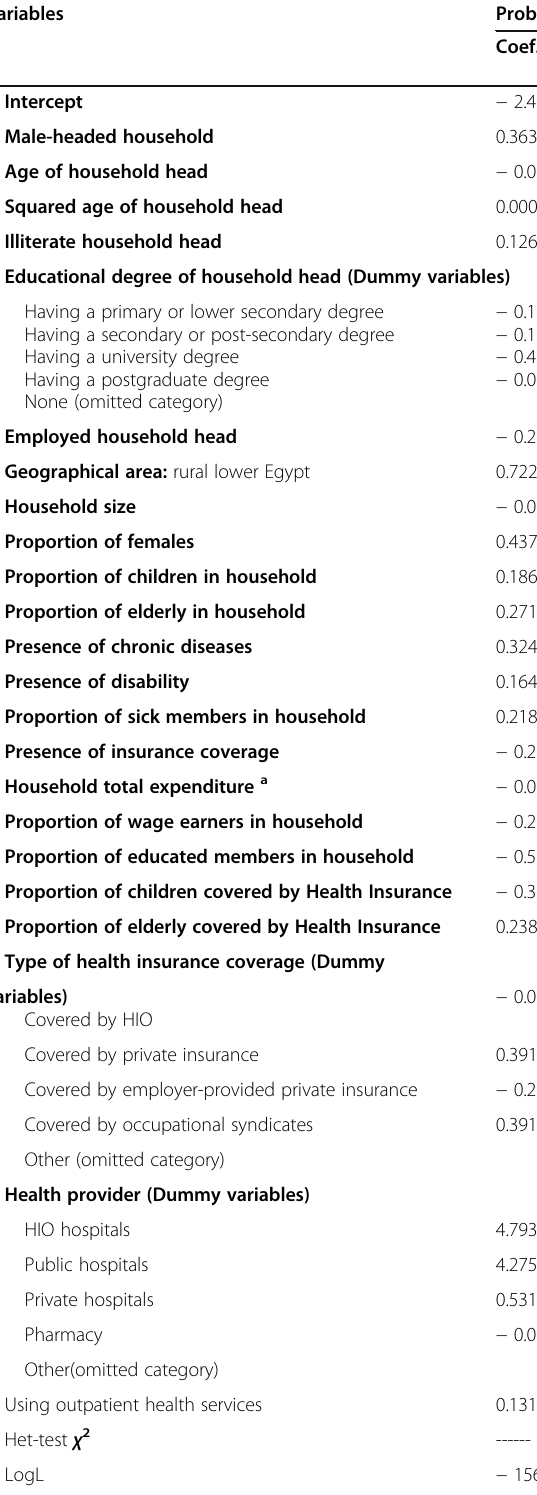
Table 1 Estimates of homoscedastic probit model and heteroskedastic probit model, HIECS,